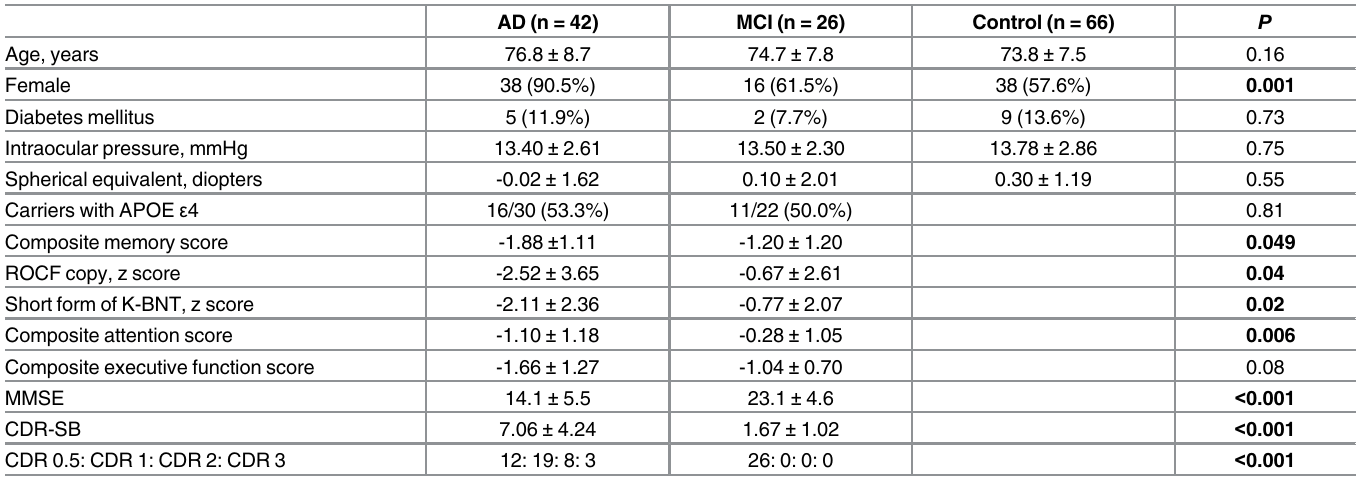
Table 1. Baseline demographic and clinical characteristics of the